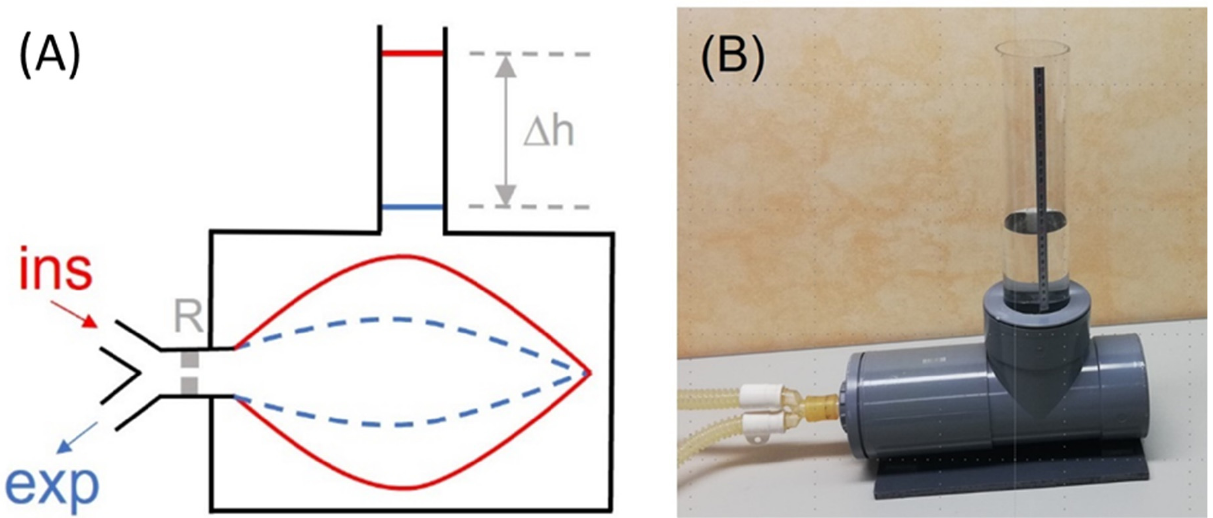
Figure 2. ( A ) Diagram of the method described for directly measuring the tidal volume (V T )